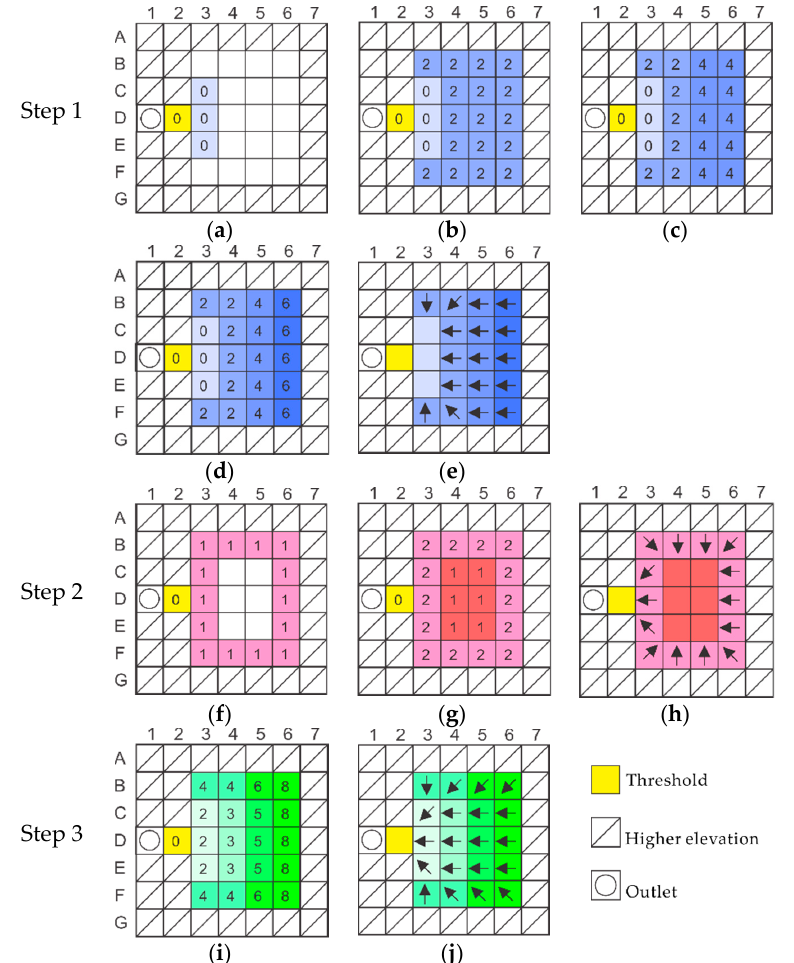
Figure 2. Increment numbers for steps 1–3 in the new algorithm (arrows represent the corrected flow directions across the flat area): ( a ) increment numbers at the beginning in step 1; ( b – d )